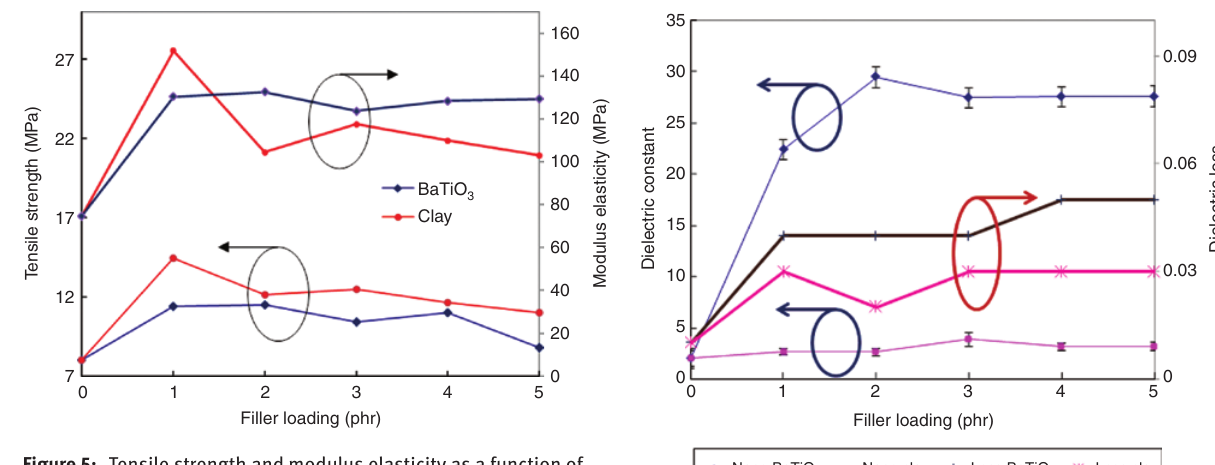
Figure 5: Tensile strength and modulus elasticity as a function of filler loading.